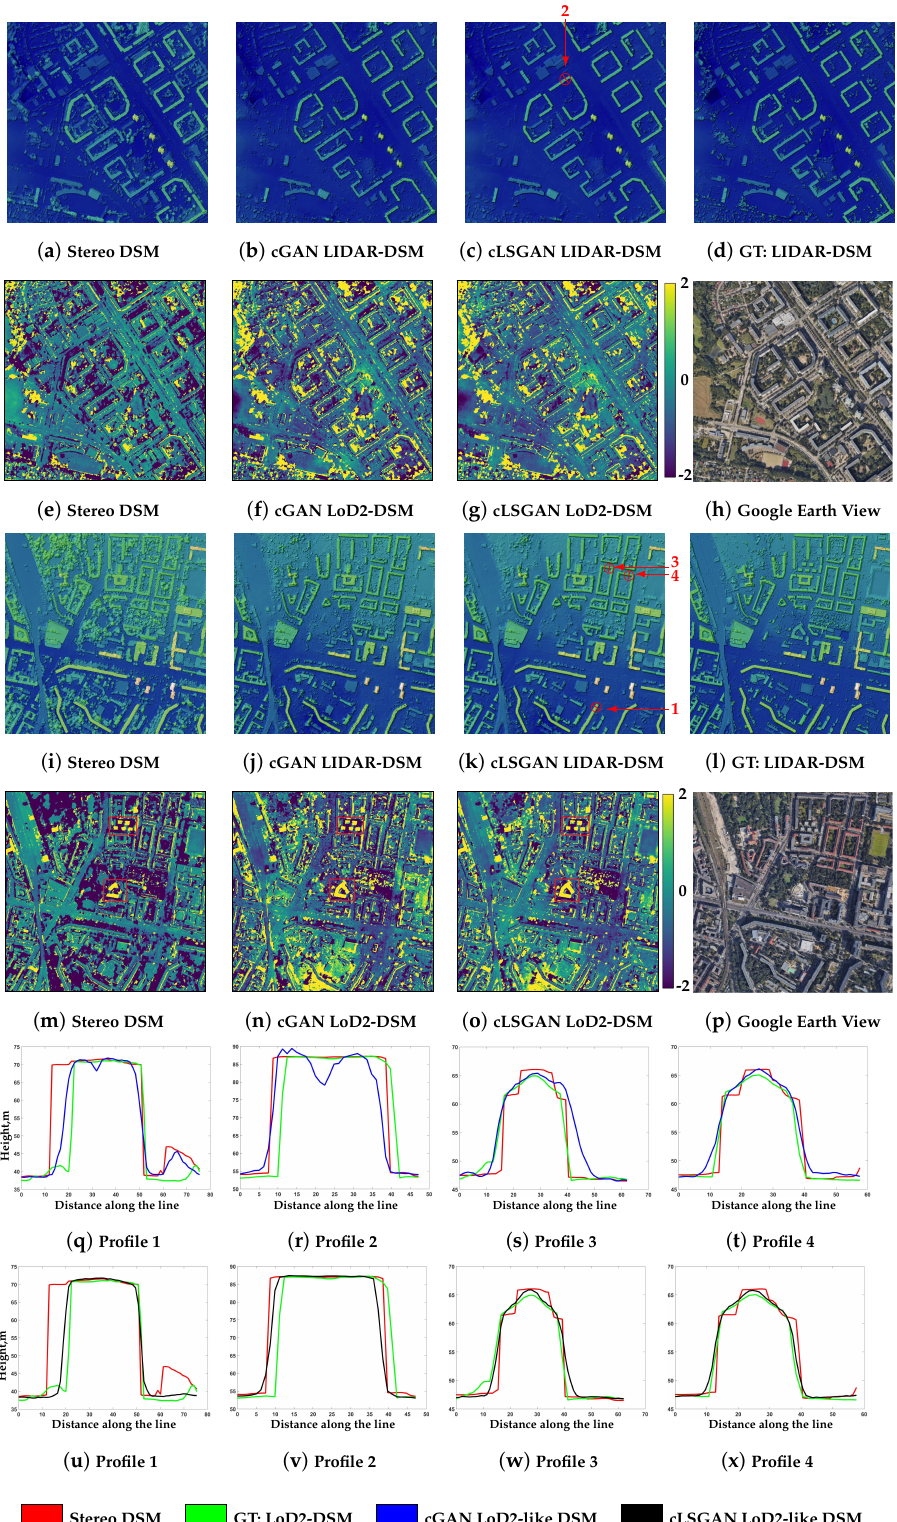
Figure 6. Visual analysis of DSMs generated by cGAN and cLSGAN architectures over selected urban areas. The DSM images are color-shaded for better visualization. Difference maps in meters of stereo and generated DSMs with respect to ground truth LIDAR-DSM of selected regions are shown in the second and fourth lines, respectively. The profiles of selected buildings from DSM generated by cGAN are illustrated in the fifth line and the ones from cLSGAN are in the sixth line.